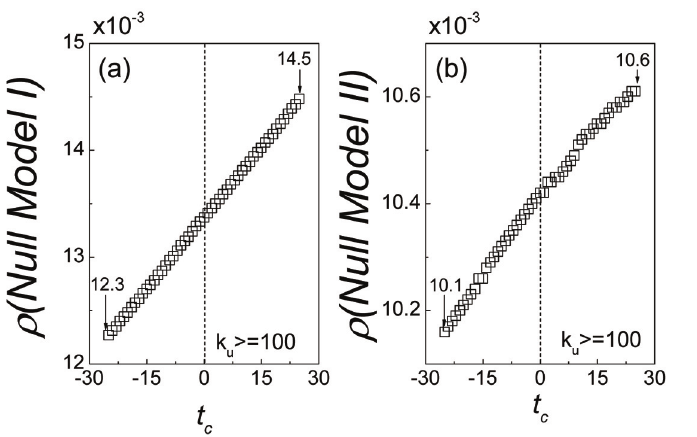
Fig 3. The dynamics of overlap rate ρ for Null models. The model I is constructed by shuffling the timestamps of the user ’ s comment series into random order. Thus the temporal patterns of the user comment behaviors are removed. The model II is generated by randomizing the trust relation creation time for each pair of users, so that the users ’ temporal trust behaviors are totally random. (a) The variation of overlap rate ρ for trust relations in Null model I. (b) The variation of overlap rate ρ for trust relations in Null model II. In both Null models, the overlap rate ρ linearly increases as the time t c increases. The results are totally different with that of the empirical data, which suggests that, if users perform randomized comment behaviors or trust behaviors, there will be no correlation between the trust formation and the accumulation of common interests. In other words, only in the real cases, the increasement of common interest overlaps will lead to the trust formation.